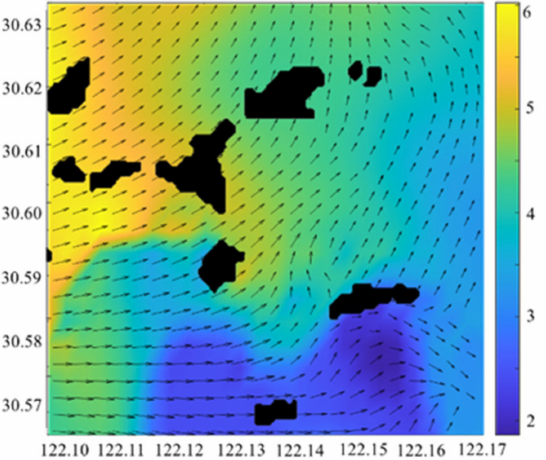
Figure 4. Wind field map of local area.